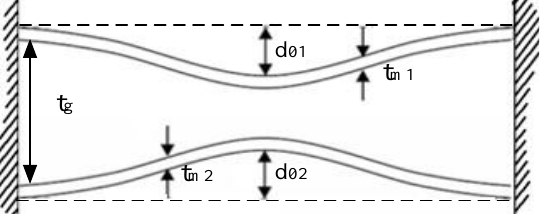
Figure 2. Deflection of membranes as a result of applied